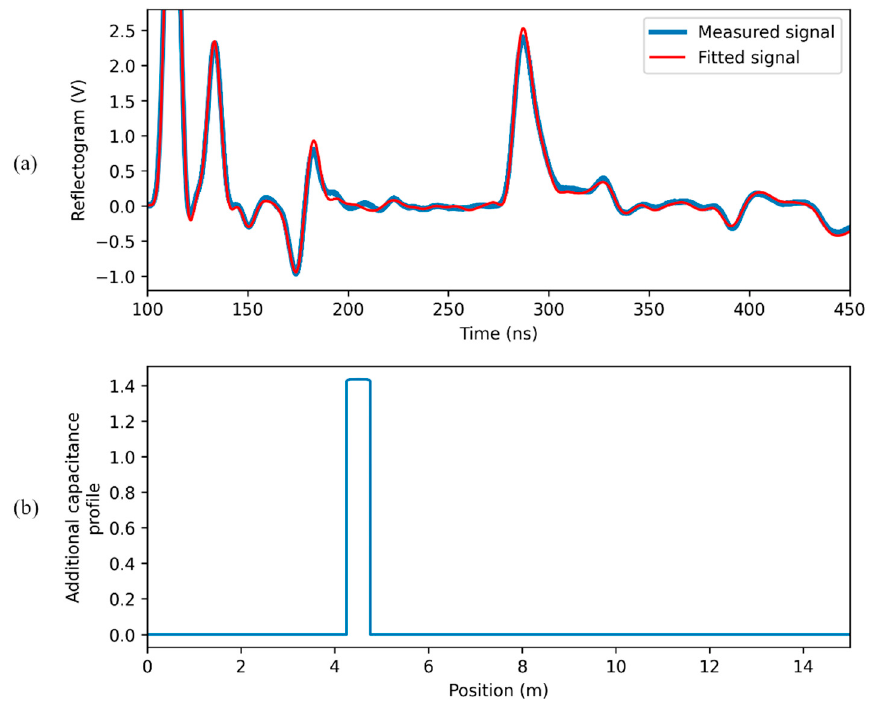
Figure 10. Results of the measurement phase for the reflectogram of Figure 7: ( a ) measured and fitting signal; ( b ) estimated additional capacitance profile.